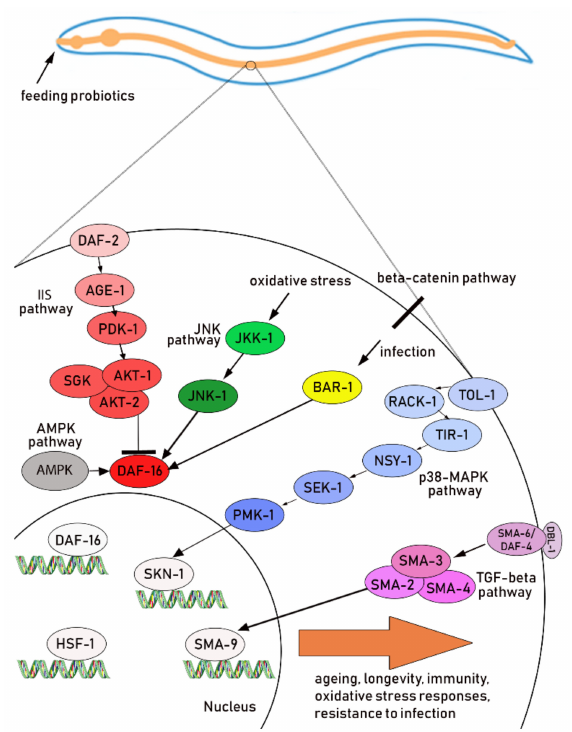
Figure 2. Schematic representation of the most common signaling pathways influenced by probiotic strains employed in C. elegans studies. Each pathway is represented by a distinct color gradient. The list of single bacterial strains influencing the di ff erent pathways is reported in Table 1.